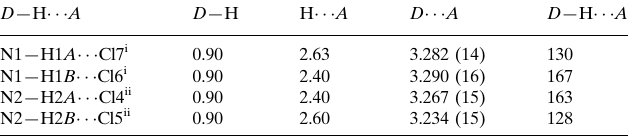
Hydrogen-bond geometry (A˚ , (cid:2)